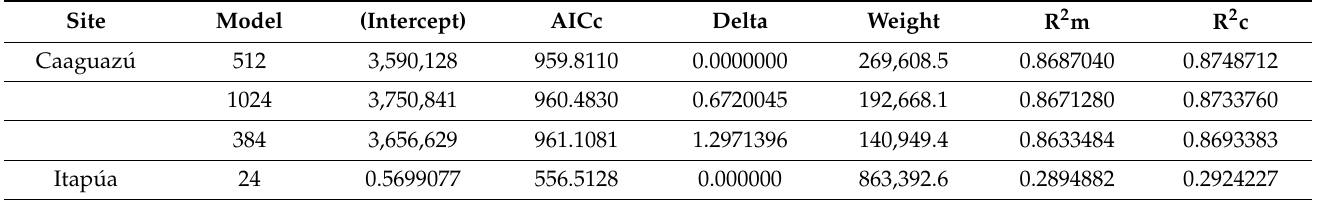
Table 2. Plausible models for the survival of planted species in the two agroforestry